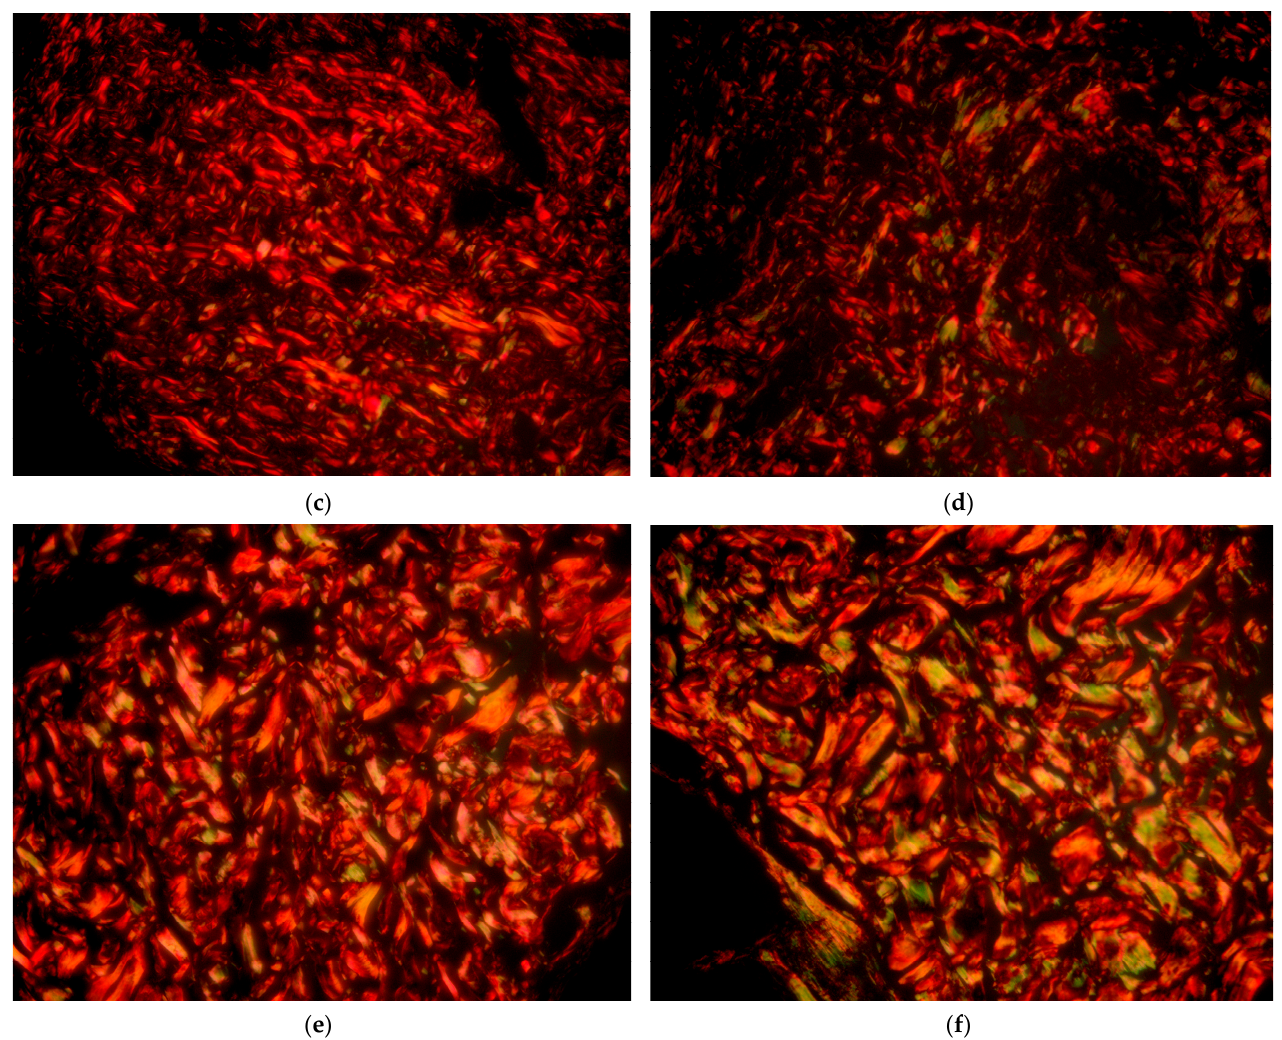
Figure 9. Micrograph of the skin section of patients: ( a ) patients with normal skin aging before treatment; ( b ) patients with normal skin aging after treatment with native hyaluronic acid; ( c ) patients with premature skin aging before treatment; ( d ) patients with premature skin aging after native hyaluronic acid; ( e ) patients with premature aging of the skin after the complex product of hyaluronic acid; ( f ) patients with premature aging of the skin after collagen. Stained by Sirius Red. Polarization microscopy, ×400.